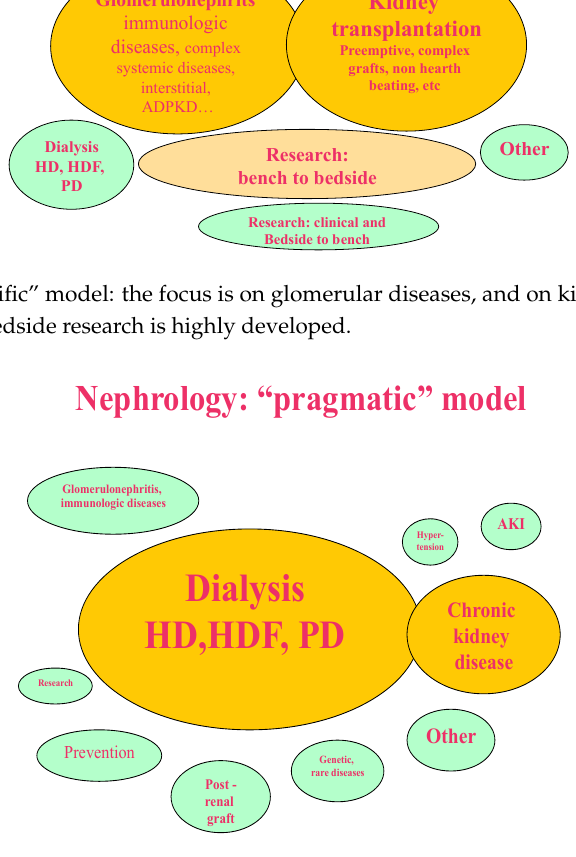
Figure 2. The “pragmatic” model: the focus is on dialysis and pre-dialysis care. Attention is on the most severe and common kidney diseases; research development is an option.